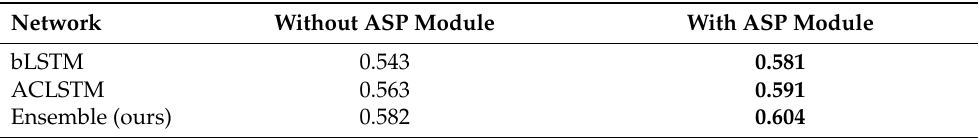
Table 8. The boundary residue Q8 accuracy of before and after using the ASP network for the bLSTM, ACLSTM and ensemble (ours) network on CB513